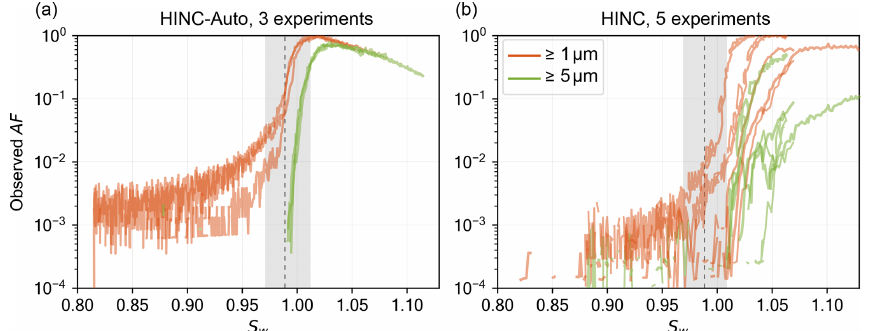
Figure 9. Activation curves of ammonium nitrate in HINC-Auto (a) and HINC (b) at T = 233K with identical particle residence times of τ ≈ 9s; the vertical dashed line indicates the expected homogeneous freezing onset of solution droplets for d 0 = 200nm and J = 10 10 cm − 3 s − 1 (Koop et al., 2000b). Sizes indicate what fractions of all particles entering the chamber grow to or beyond the indicated size. Grey shading refers to chamber uncertainty (see Lacher et al., 2017, for details on HINC and Sect. 3.1 for details on